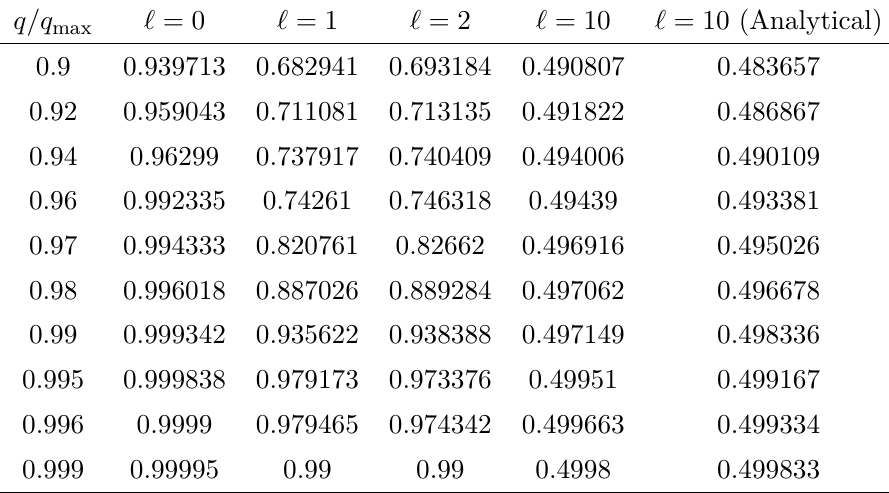
Table 2 . Numerical values of the ratio {− ( Im ω n,l ) /κ − } have been presented for the lowest lying QNMs for different choices of the angular momentum ‘ and the ratio ( q/q max ) . Here we have considered the value of the AdS length scale and the mass to be, L = 2 and M = 1 ,